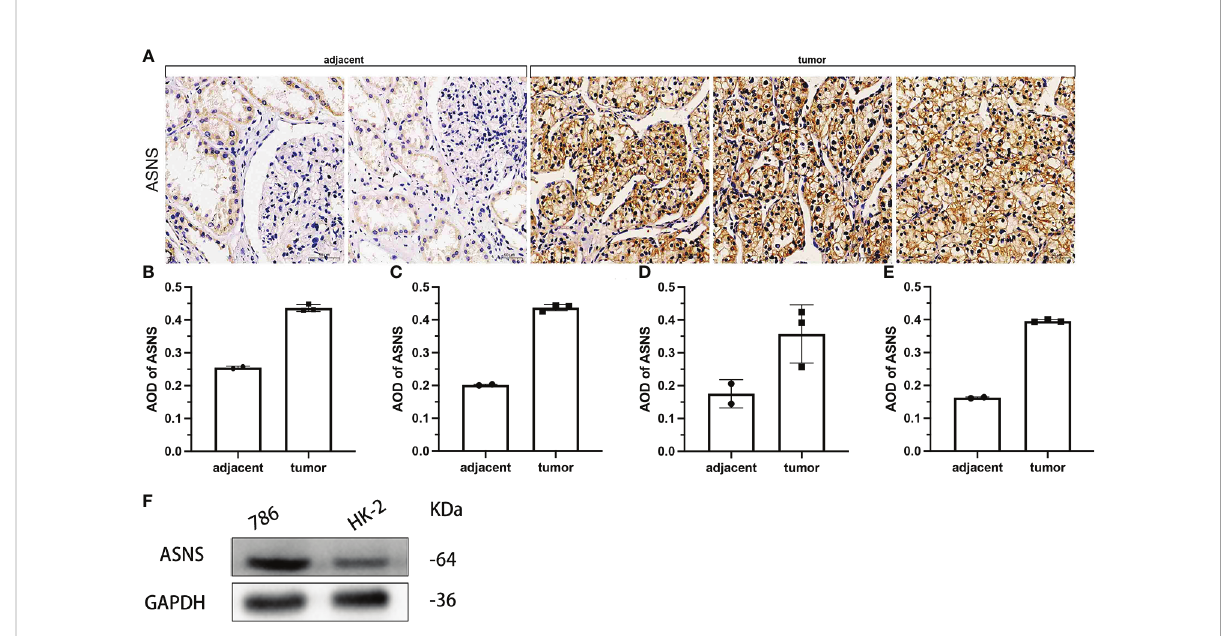
FIGURE 8 Validation of ASNS in cells and pathological tissues of ccRCC. (A) Results of immunohistochemical analysis of ASNS in ccRCC tissues and adjacent normal tissues. (B – E) Quantitative immunohistochemical analysis results of ASNS in four samples. (F) Western blot result of ASNS in 786-O and HK-2 cells.